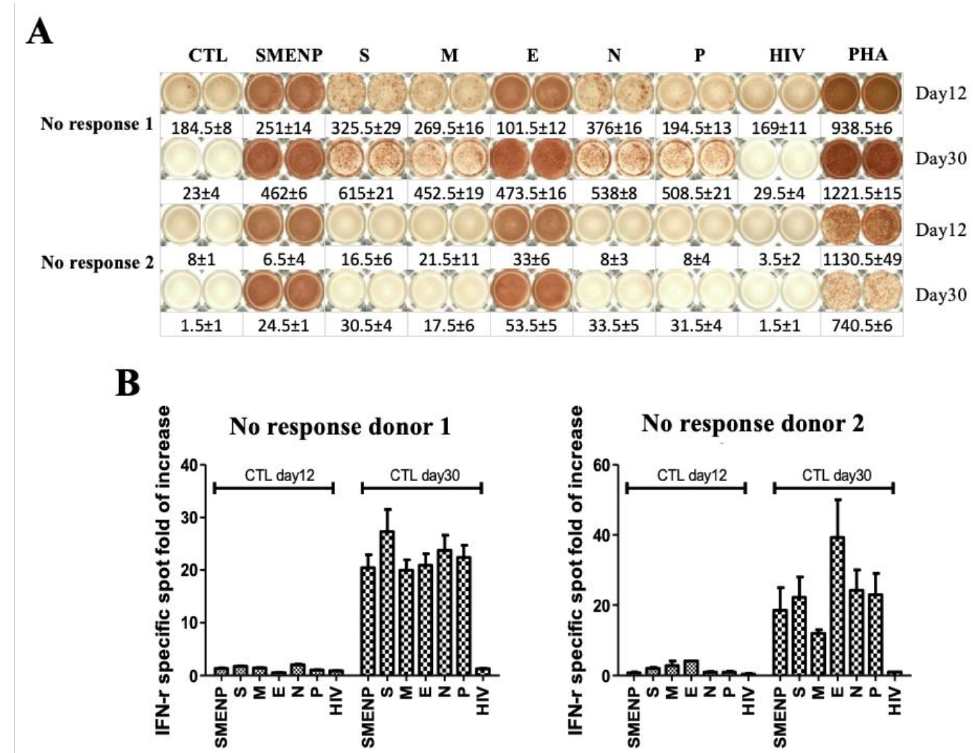
Figure 4. Secondary DC/T-cell activation at 30 days against SARS-CoV-2 antigens. ( A ) IFN- γ ELISPOT assay of two no responders after secondary antigen activation. The T cells after primary and secondary DC activation were cultured for 30 days from two no response donors. PHA served as a positive control, and HIV-1 peptide pools and CTL without antigen stimulation served as background controls. ( B ) The comparison of primary day 12 versus secondary day 30 IFN- γ spot expansion folds of T cells against indicated target